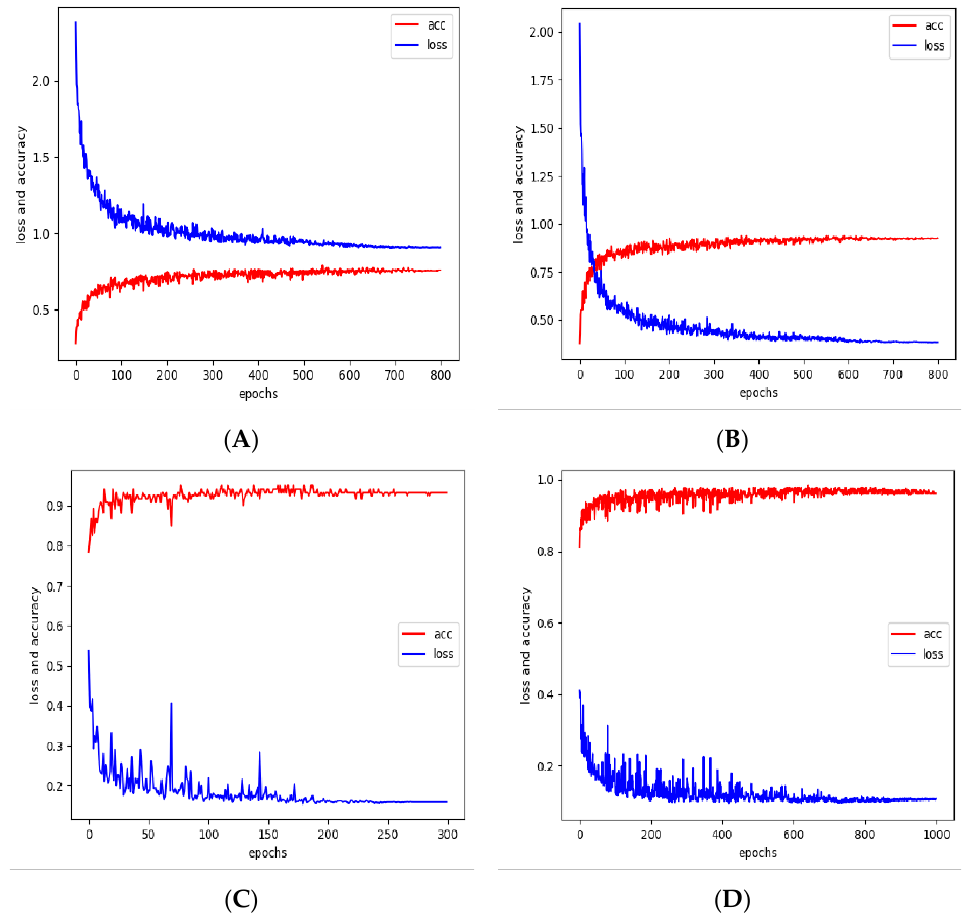
Figure 12. Line graph of loss value vs. accuracy with epochs for JHMDB and KTH datasets: ( A ) JHMDB; ( B ) enhanced JHMDB; ( C ) KTH; ( D ) enhanced KTH.